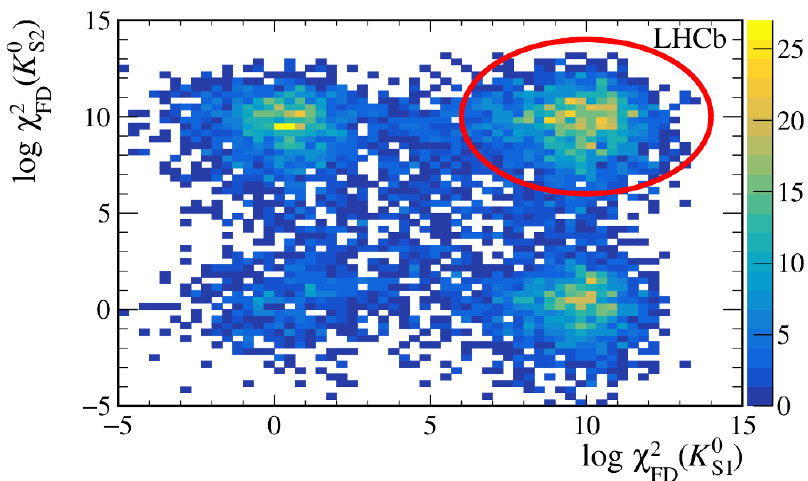
(cid:13)ight distance signi(cid:12)cance S K 0 decays. The D 0 ! K 0 S S